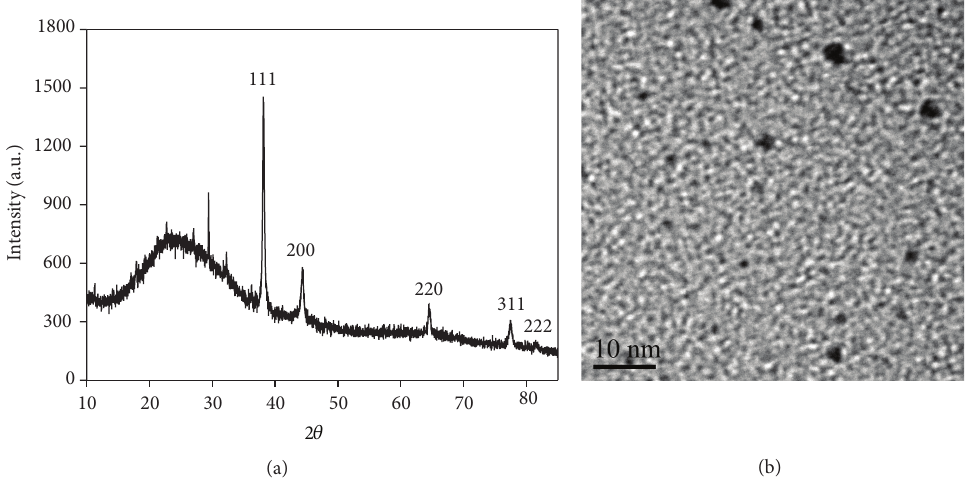
Figure 1: (a) The XRD pattern and (b) TEM image of Ag NCs.